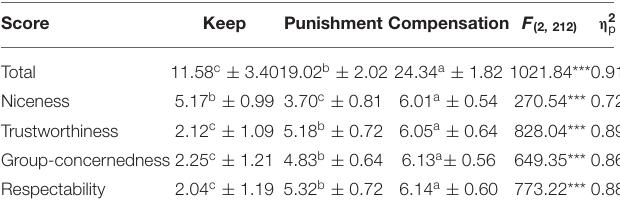
TABLE 2 | The difference in the reputational scores when third parties were free to choose ( M ± SD ). Score